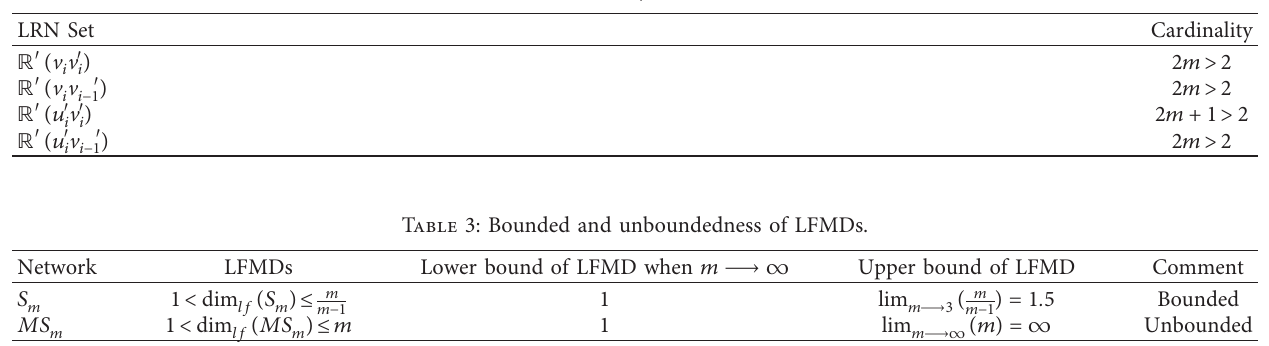
Table 2: Cardinality of each LRN